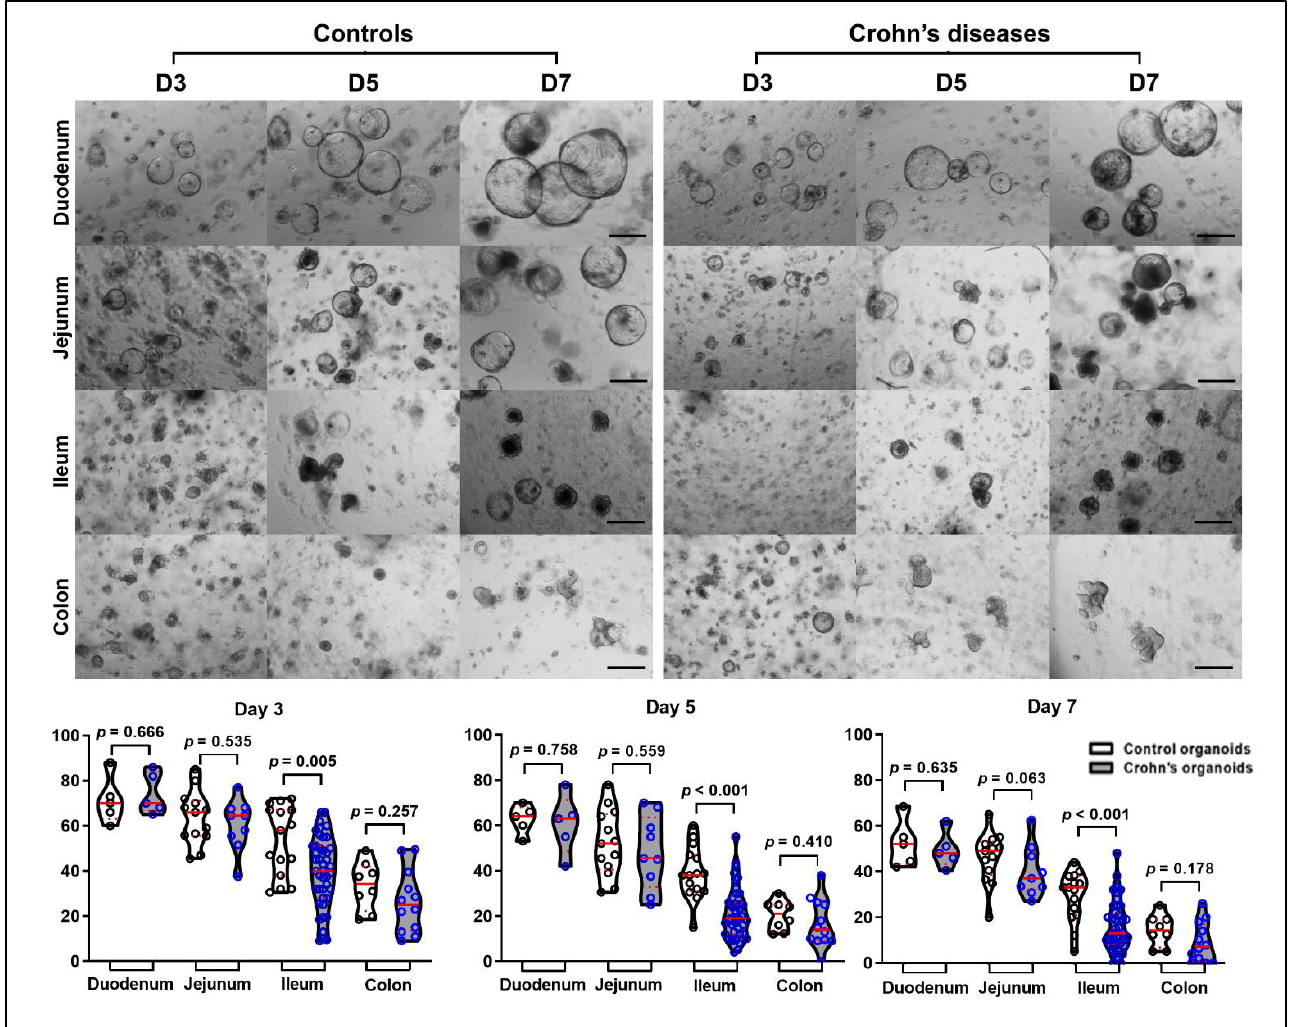
Figure 1. Organoid-forming efficiency. Intestinal crypts were isolated from the duodenum ( n = 5), jejunum ( n = 9), ileum ( n = 43), and colon ( n = 12) of patients with CD and the duodenum ( n = 5), jejunum ( n = 13), ileum ( n = 15), and colon ( n = 8) of controls. Differences in organoid-forming efficiency between controls and CD patients based on the location of GI tract were assessed by t -test; Scale bar = 200 μm.